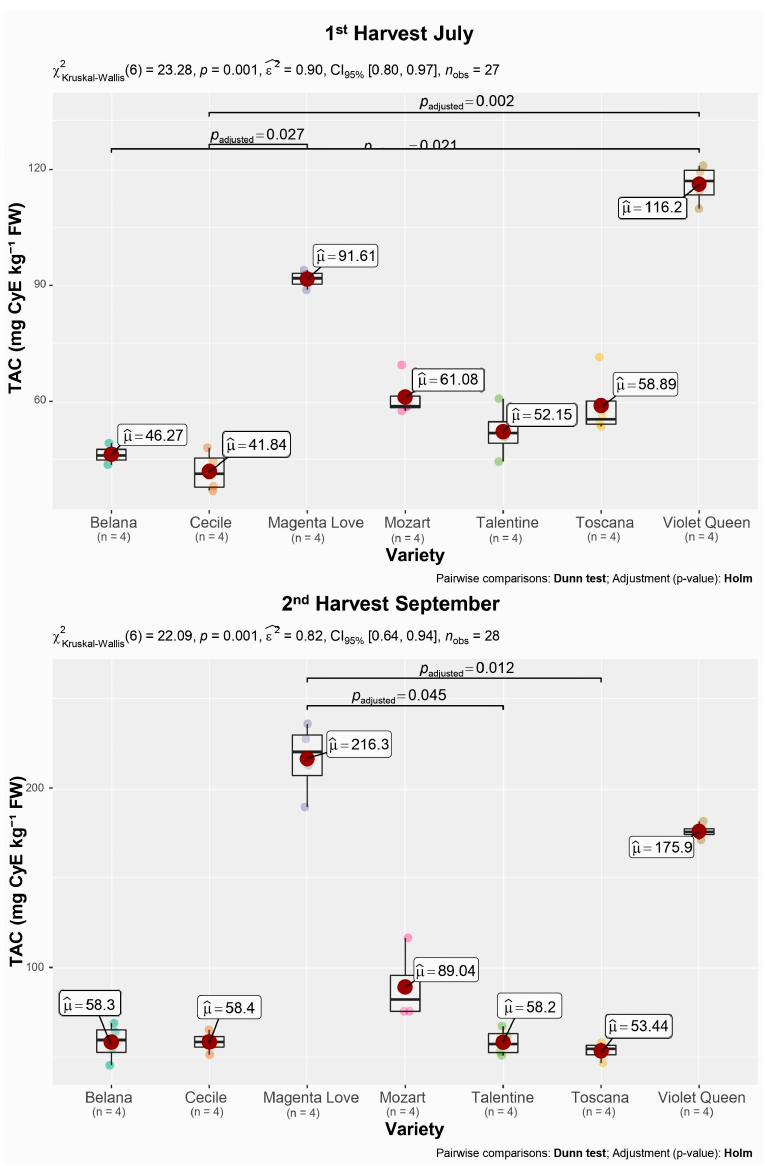
Figure 1. Statistical differences in total anthocyanin content (TAC) between individual potato varieties harvested in July (1st harvest) and September (2nd harvest).